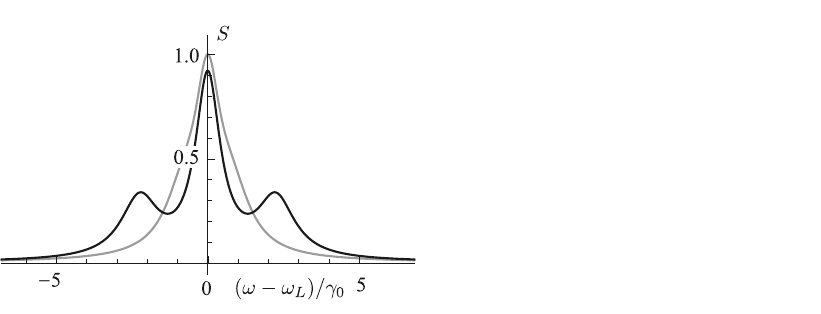
Figure 7. Resonant fluorescence spectra of a two-level QE with γ 0 = 20 MHz, in free space (gray line) and near a nanosphere (black line) with a radius of a = 20 nm at a distance of 20 nm from the nanosphere surface and θ = 0.3 rad (17 ◦ ) in a weak laser field. λ = 632.8 nm, E 0 = 500